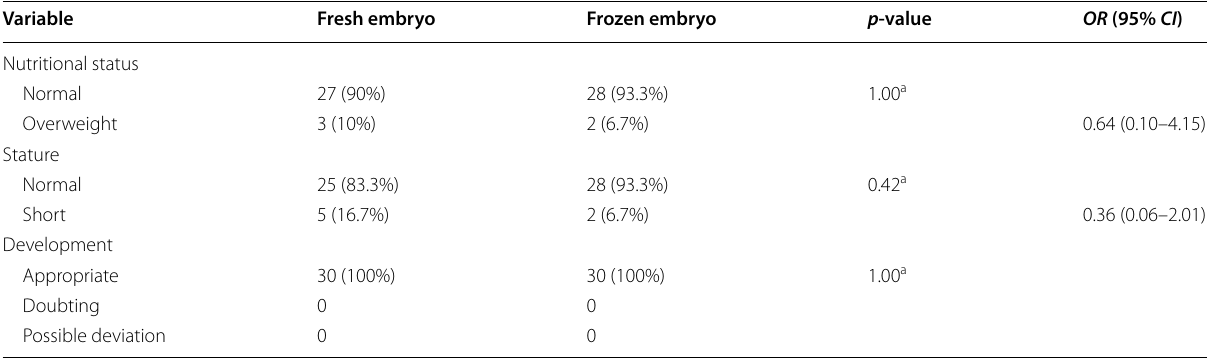
Table 4 Growth and development of children at the age of 0 to 3